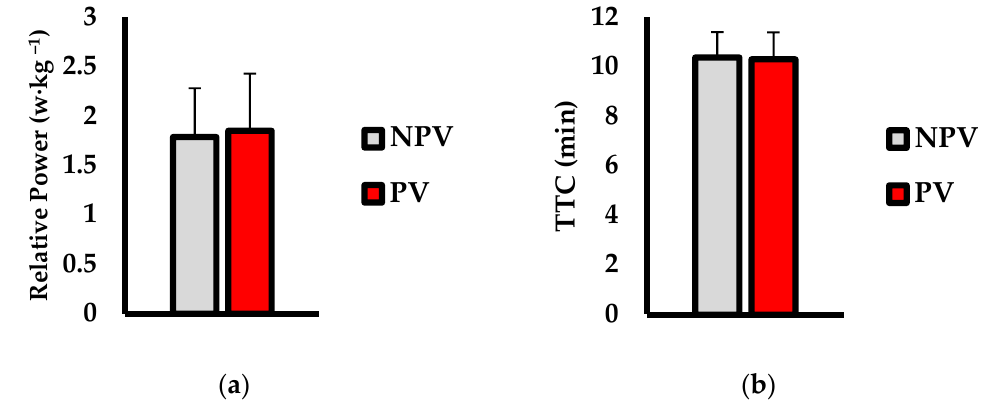
Figure 2. Comparisons of ( a ) relative power output (w · kg − 1 ), ( b ) time to completion (TTC; min) between non-preferred volume (NPV) and preferred volume (PV) conditions. Data are presented as mean ± SD.